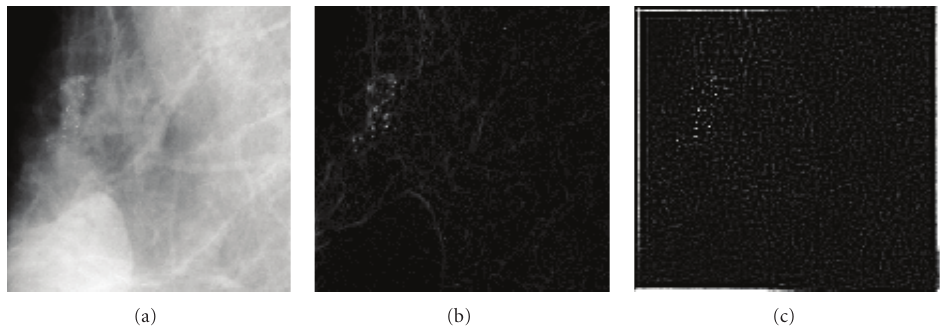
Figure 8: Feature extraction of microcalcifications: (a) original image, (b) texture features extracted using point discontinuity, and (c) spectral features extracted using wavelet based highpass filtering of image shown in